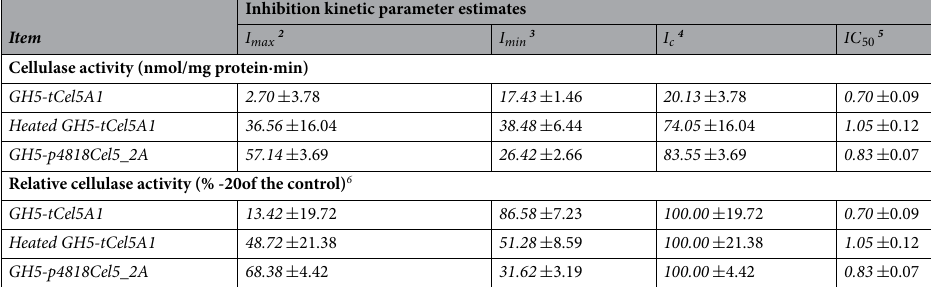
affect exogenous fibre enzyme stability. The incubation medium pH, the exocrine pancreatic proteases’ activity